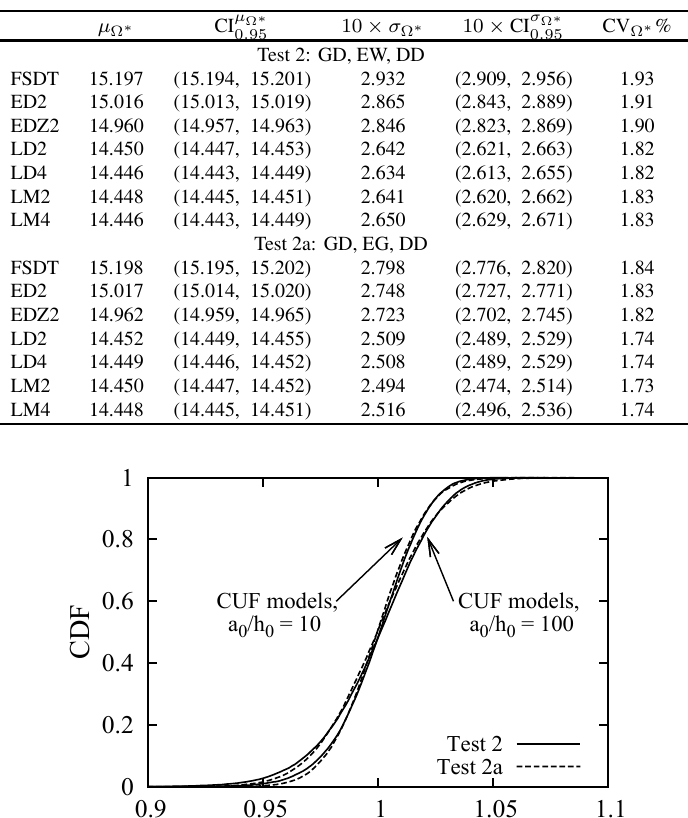
Ω ∗ statistic estimators in the case of the anti-symmetric laminate, fi rst material and a 0 /h 0 = 10.